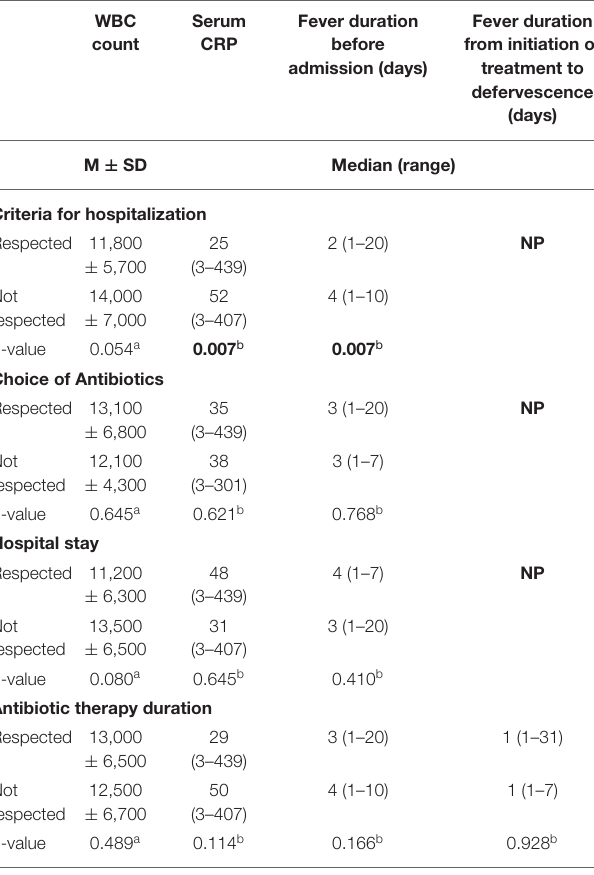
TABLE 2 | Distribution of adherence to recommendations’ rates in children hospitalized for CAP according to clinical factors.